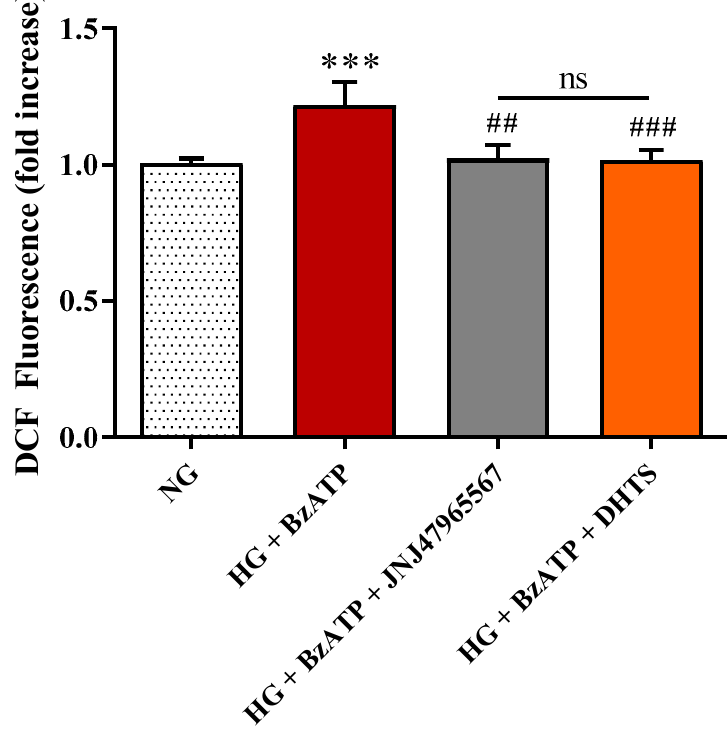
Figure 6. Intracellular ROS production in endothelial cells under our experimental conditions. NG = normal glucose condition (5 mM). HG = high glucose condition (40 mM). BzATP = 200 µM. JNJ47965567 = 100 nM. DHTS = 500 nM. Values are reported as means ± SD of three independent experiments. Statistical analysis was performed using one-way ANOVA with Tukey’s post-hoc analysis. *** p < 0.001 vs. NG. ## p < 0.01 vs. HG + BzATP. ### p < 0.001 vs. HG + BzATP. ns = not significant.